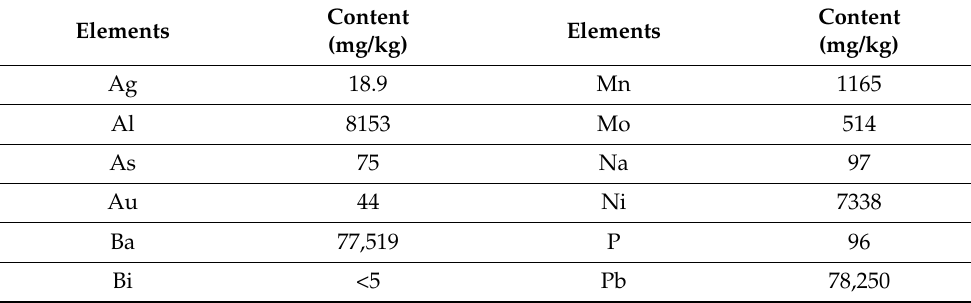
Table 1. Elemental composition of gold sulfide